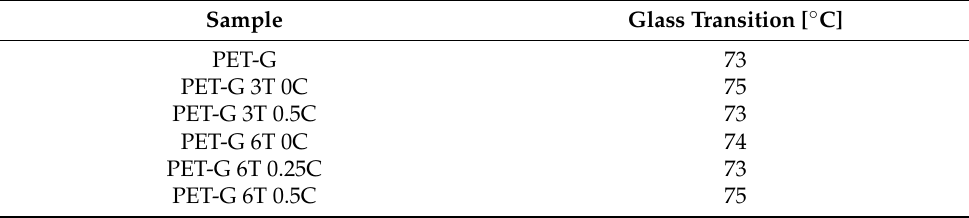
Figure 5. Graphical representation of DSC test results of PET-G and composite samples . Table 4. DSC test results of PET-G and composite samples .